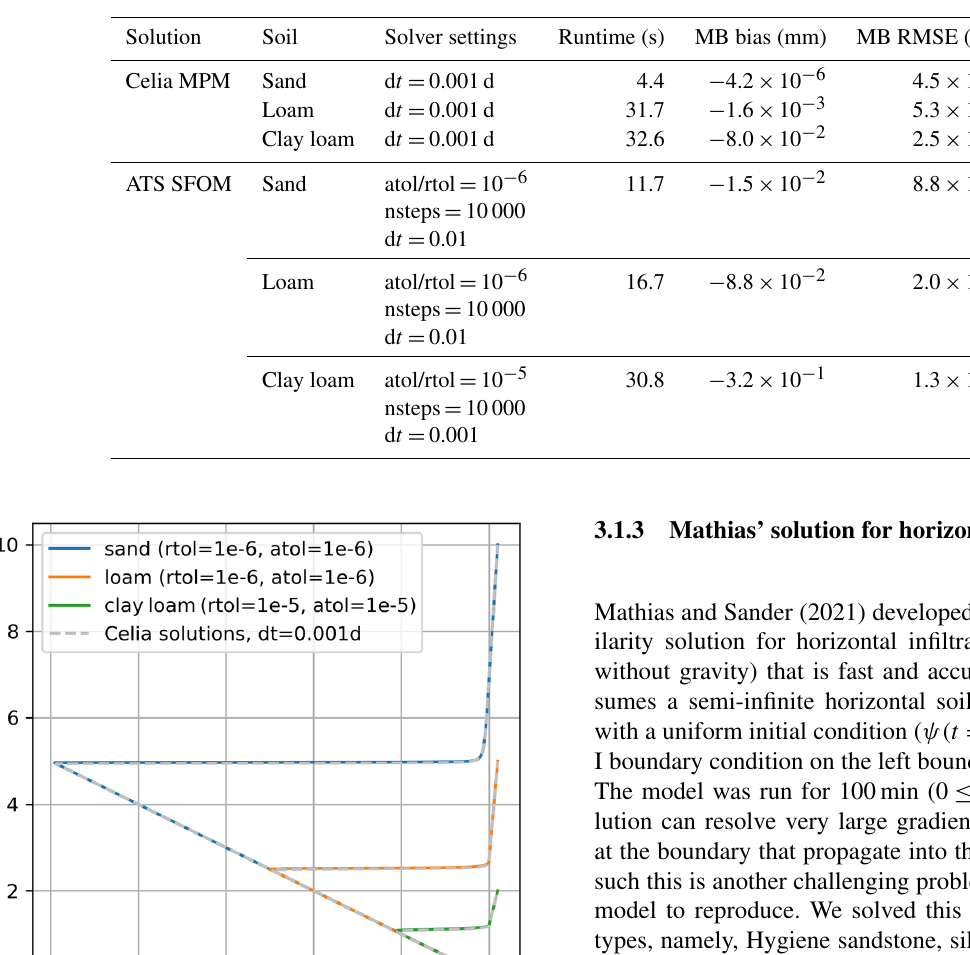
Table 2. Runtime and water balance performance for the Celia MPM and ATS SFOM solutions, applied to the problem in Miller et al. (1998). We also show here the solver settings. For the ATS solutions, we had to reduce the relative and absolute tolerances (atol/rtol) of the integrator from the default settings and increase the maximum number of calculations steps allowed within a reporting step (nsteps). Note that time steps (d t ) in ATS solutions are reporting time steps.